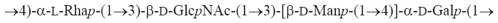
Tetrasaccharide repeating unit corresponding to the O-specific lipopolysaccharide of Escherichia coli O75.